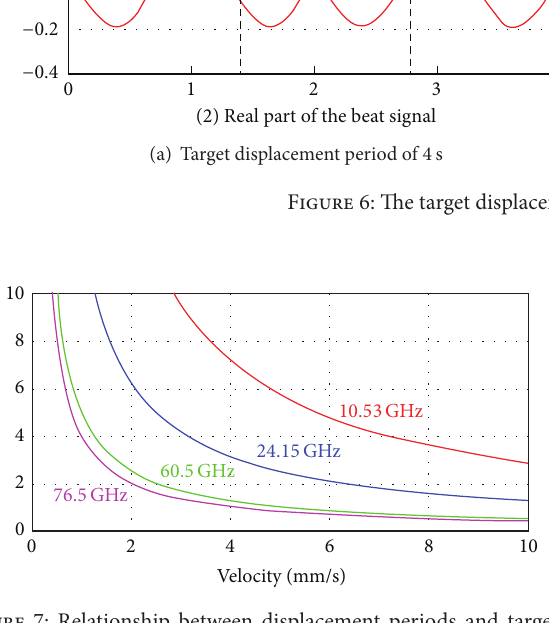
Figure 7: Relationship between displacement periods and target velocities for propagation